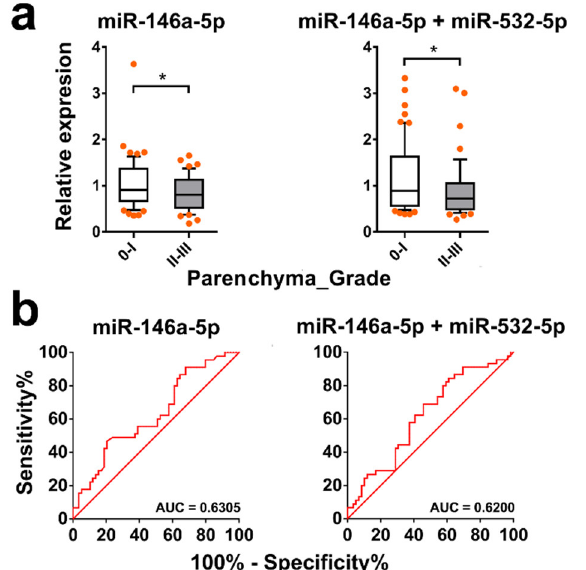
Figure 8. Discrimination of schistosomiasis hepatic fibrosis grades II–III vs. 0–I by serum levels of exomiRs. ( a ) The level of serum exosomal miR-146b-5p or a combination of exosomal miR-146a-5p and miR-532-5p in subjects with grades 0–I or II–III liver fibrosis. Boxes represent the interquartile range of the data with lines across the boxes indicating the median values. The hash marks above and below the boxes indicate the 90th and 10th percentiles, respectively. p values were calculated using a Mann – Whitney U test (* = p < 0.05). ( b ) The AUC values were calculated using ROC analysis to access capabilities of exomiR candidates individually or in combination in serum for discriminating subjects with severe fibrosis grades (II – III) from those without significant fibrosis (grades 0 – I).